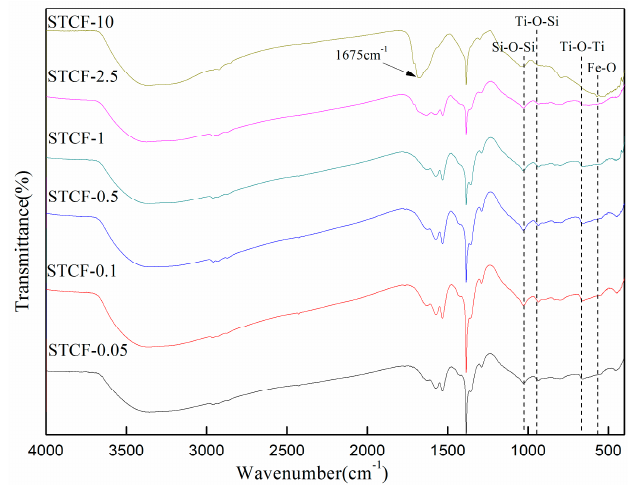
Figure 3. FTIR spectra of SCF, TCF, and STCF.